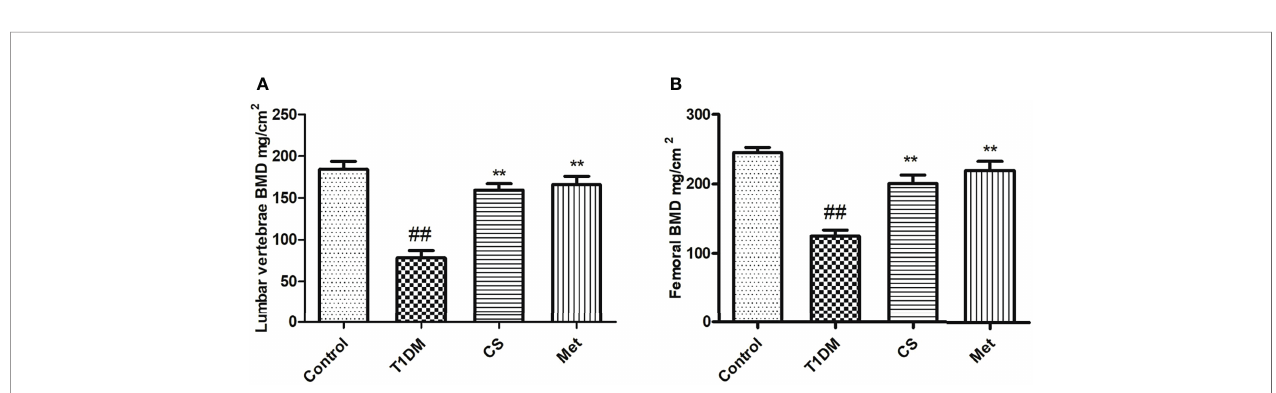
FIGURE 2 | The bone mineral density of different groups at the end of the 10th week. (A) The BMD of lumbar vertebrae in different groups. (B) The femoral BMD in different groups. ## indicates p < 0.01 compared with control. **indicates p < 0.01 compared with the diabetic group.